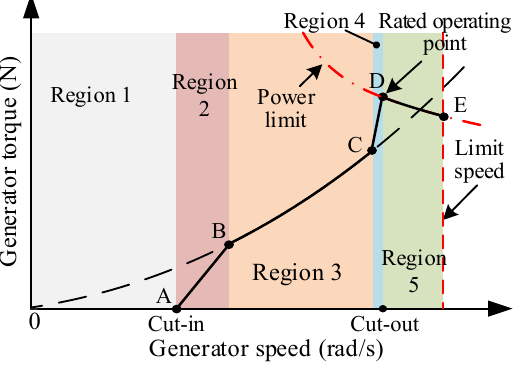
Figure 4. Flowchart of the control system.